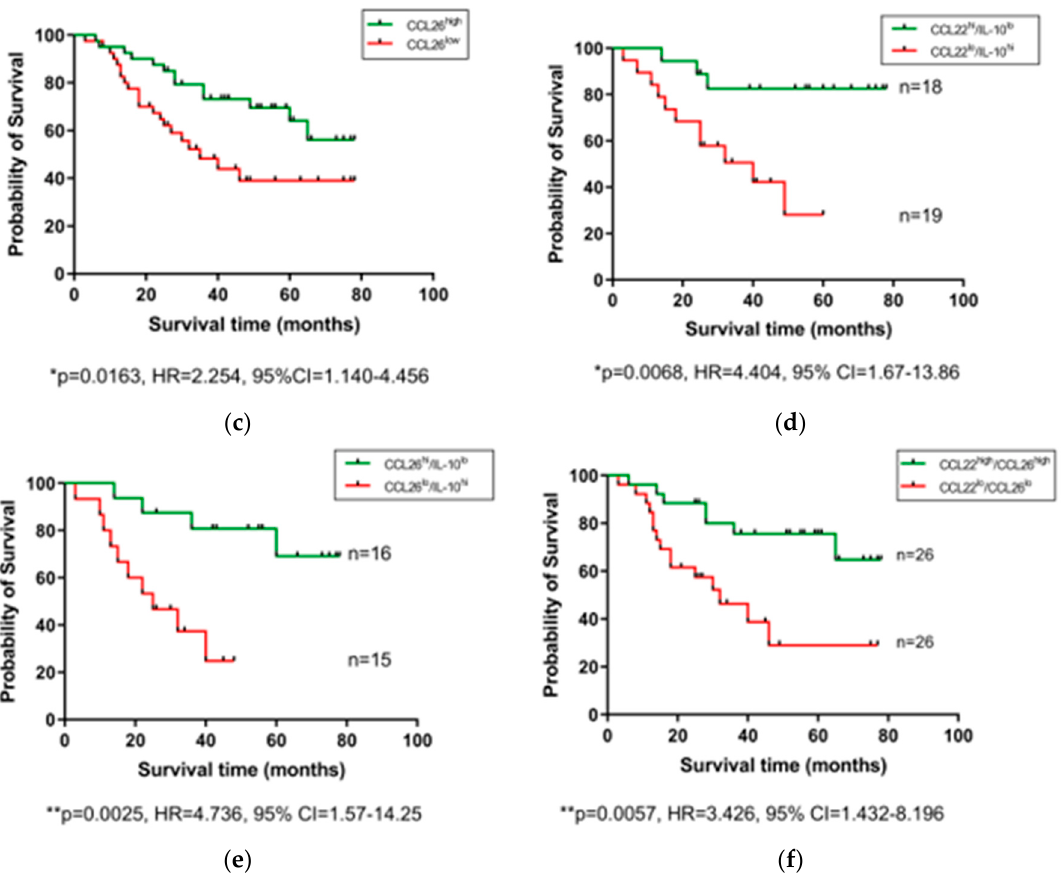
Figure 3. Serum IL-10, CCL22, and CCL26 levels are linked with overall survival. Groups were divided into cytokine high and low populations using the median cytokine level as a cut-off and OS was visualized using Kaplan–Meier curves. Elevated IL-10 was associated with a shorter OS time ( a ), whereas elevated levels of CCL22 ( b ) and CCL26 ( c ) were associated with longer OS time. Combining cohorts of patients with favorable cytokine conditions also showed a survival advantage, e.g., for CCL22 hi /IL-10 lo ( d ) CCL26 hi /IL-10 lo ( e ) and CCL22 hi /CCL26 hi cohorts ( f ). Log-rank (Mantel–Cox) tests were performed to assess median survival time differences between groups and data were visualized using Kaplan–Meier curves. OS = Overall Survival, IL = Interleukin.